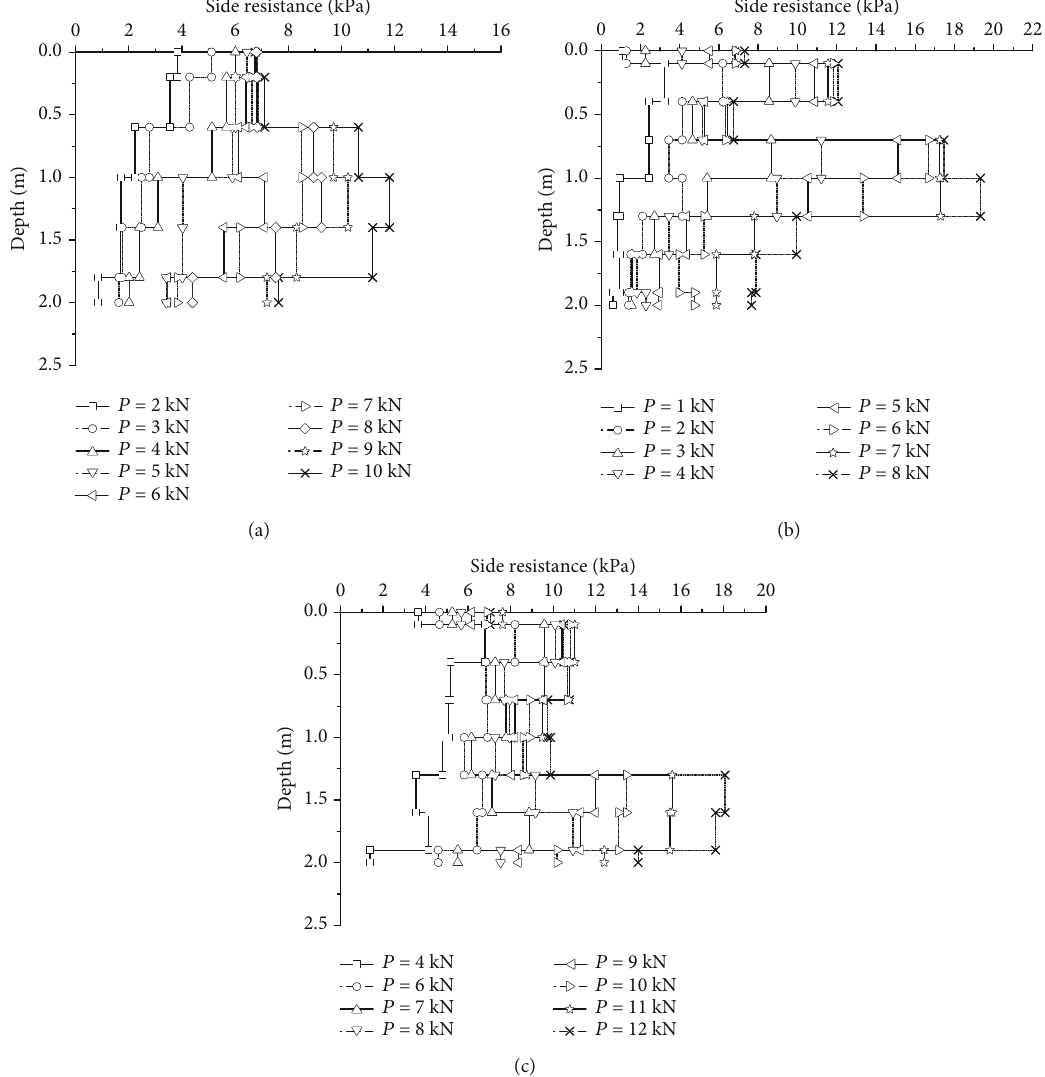
Figure 8: Side resistance distributions along pile depth: (a) Y pile; (b) C